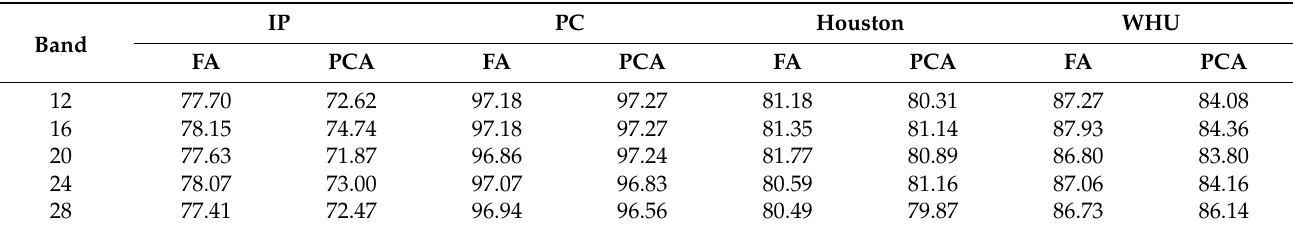
Table 9. OA results (%) of different band number using FA and PCA.